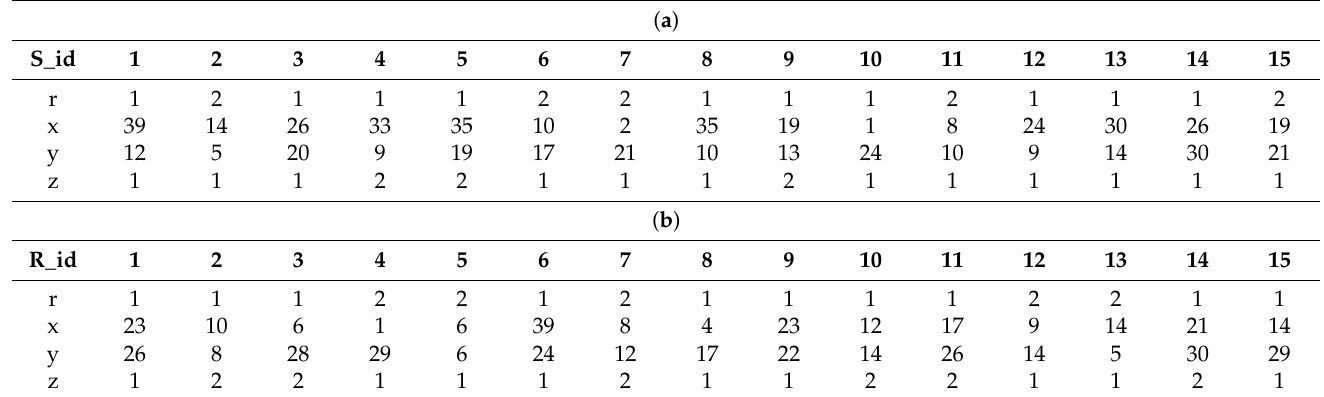
Table 2. ( a ). The storage requests ( N = 15). ( b ). The retrieval requests ( N = 15). ( a )